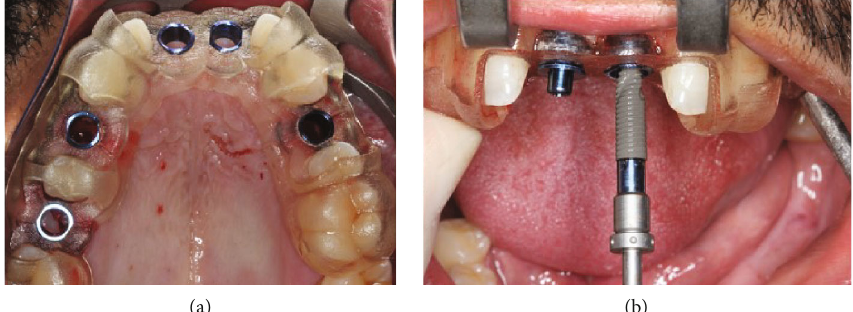
Figure 3: Tooth-supported surgery guide positioned in maxilla (a). Implant driver with stopper that indicates when the implant reaches the planned position